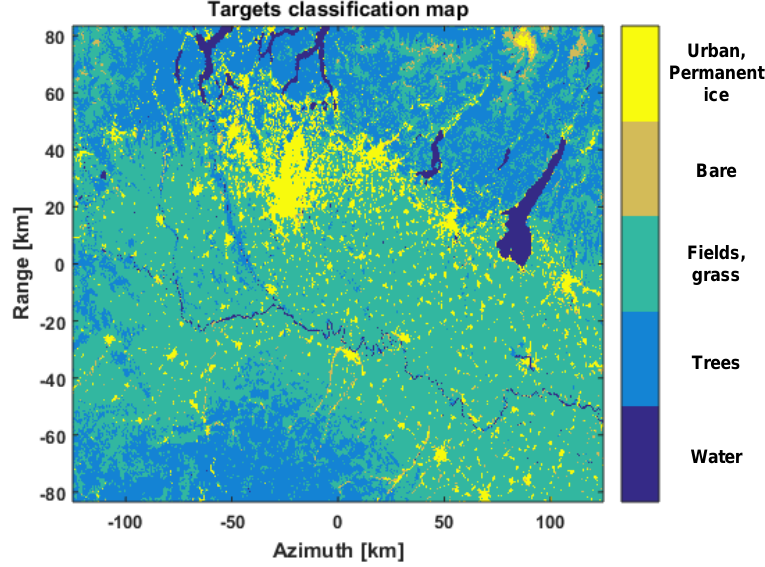
Figure 20. Classification map of the targets to be simulated.